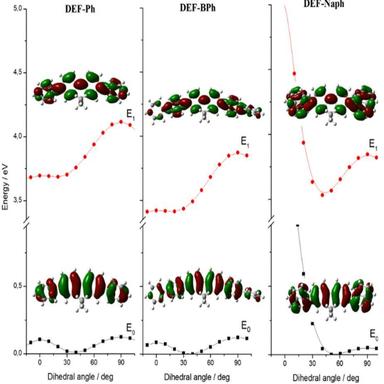
Potential energy diagrams of DEF-Ar compounds. Ground state S0 and lowest excited state S1 energy dependence on dihedral angle ϕ between core and fragment substituents (–Ph, –BPh, –Naph, respectively). Molecular charge distributions at HOMO (bottom) and LUMO (top) in X0Y projection for pure Franck-Condon transition at minimum of ground state energy distribution: ϕM = ~40 deg for DEF-Ph and DEF-BPh and ϕM = ~50 deg for DEF-Naph. Simulations using semiempirical TD (singlets) method with solvent impact (chloro